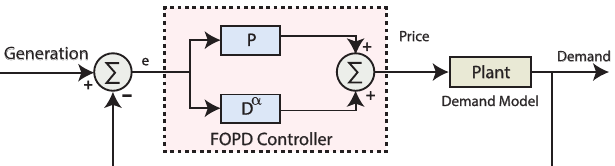
Figure 4. Block diagram of simulations using a fractional order proportional derivative (FOPD) controller in closed-loop elastic demand